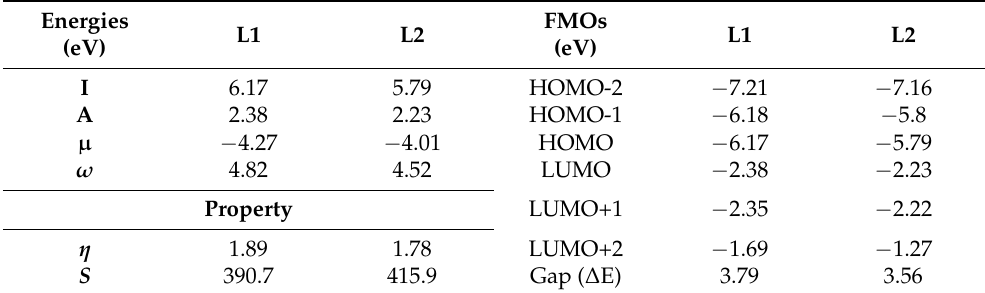
Table 4. Different energies, hardness, and softness of L1 and L2 in the gas phase as well as energies of FMOs (eV) and orbital gaps ( ∆ E) of L1 and